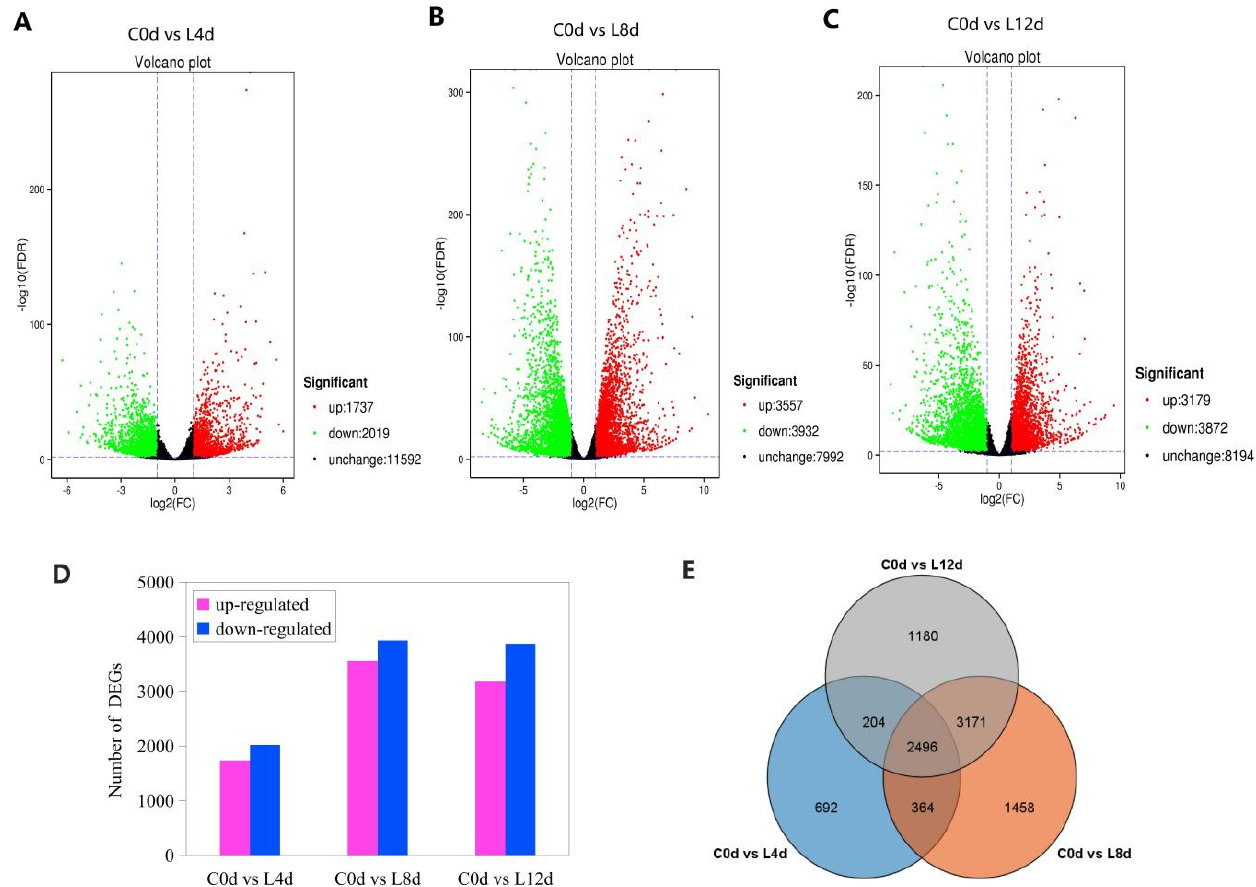
Figure 4. Differentially expressed genes ( A – D ) and Venn diagram of the DEGs ( E ) in response to chilling stress. ‘Huaizhi’ litchi trees were grown in a chamber with 22 °C/17 °C (day/night temperature, 12 h day and 12 h night) as the normal temperature. Temperatures dropped from the normal one to 2 °C for 4 d, and then were maintained at 2 °C for another 8 d. C0d, L4d, L8d, and L12d mean the leaves samples at 0 d, 4 d, 8 d, and 12 d of chilling stress.